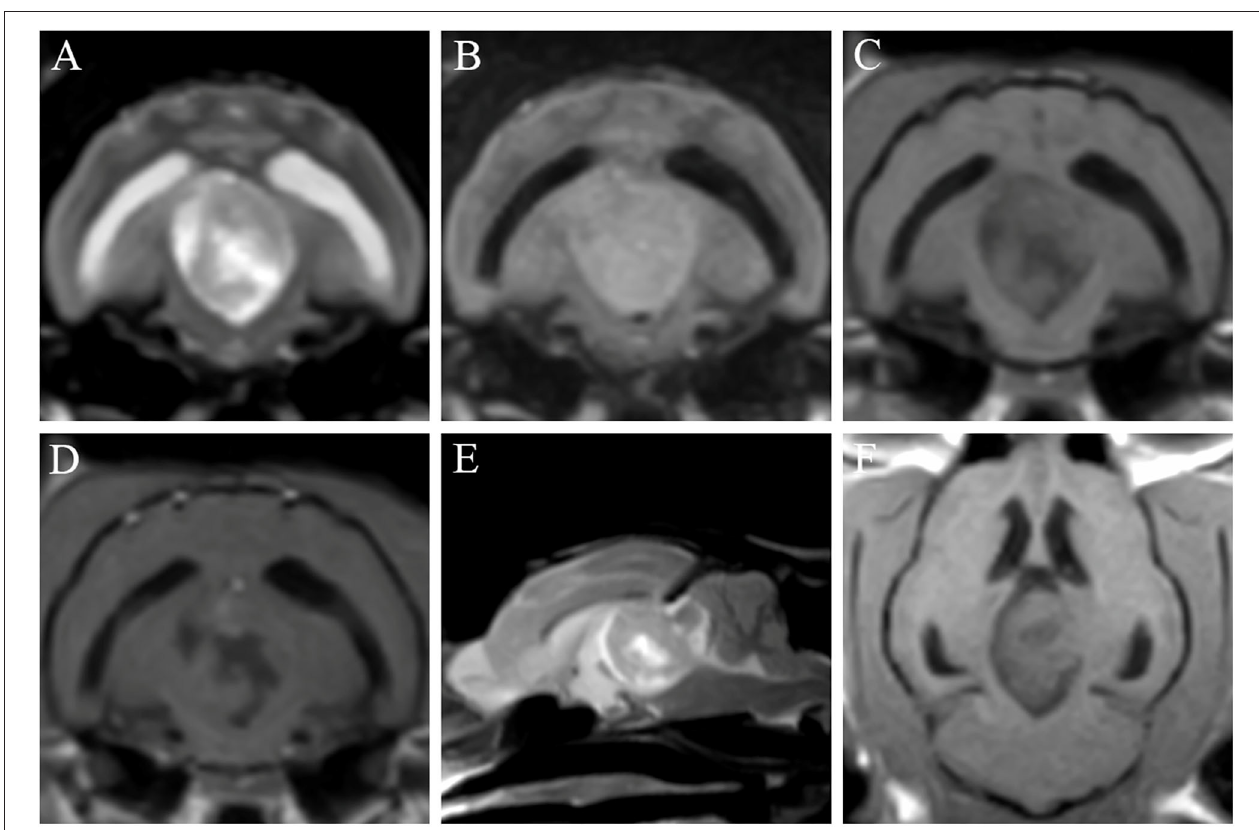
FIGURE 1 | Findings of the first magnetic resonance imaging of a cat with a meningioma. T2-weighted (A,E) , fluid-attenuated inversion recovery (FLAIR) (B) , T1-weighted (C,F) , and post-contrast (D) images were obtained. An oval-shaped mass is identified in the third ventricle, showing mass effects on the rostral cerebellum, brainstem, and occipital cortex. The mass appears hypointense-to-isointense in T1-weighted images (C,F) and isointense-to-hyperintense in T2-weighted (A,E) and FLAIR (B) images. The lesion is heterogeneously enhanced in the post-contrast image (D)